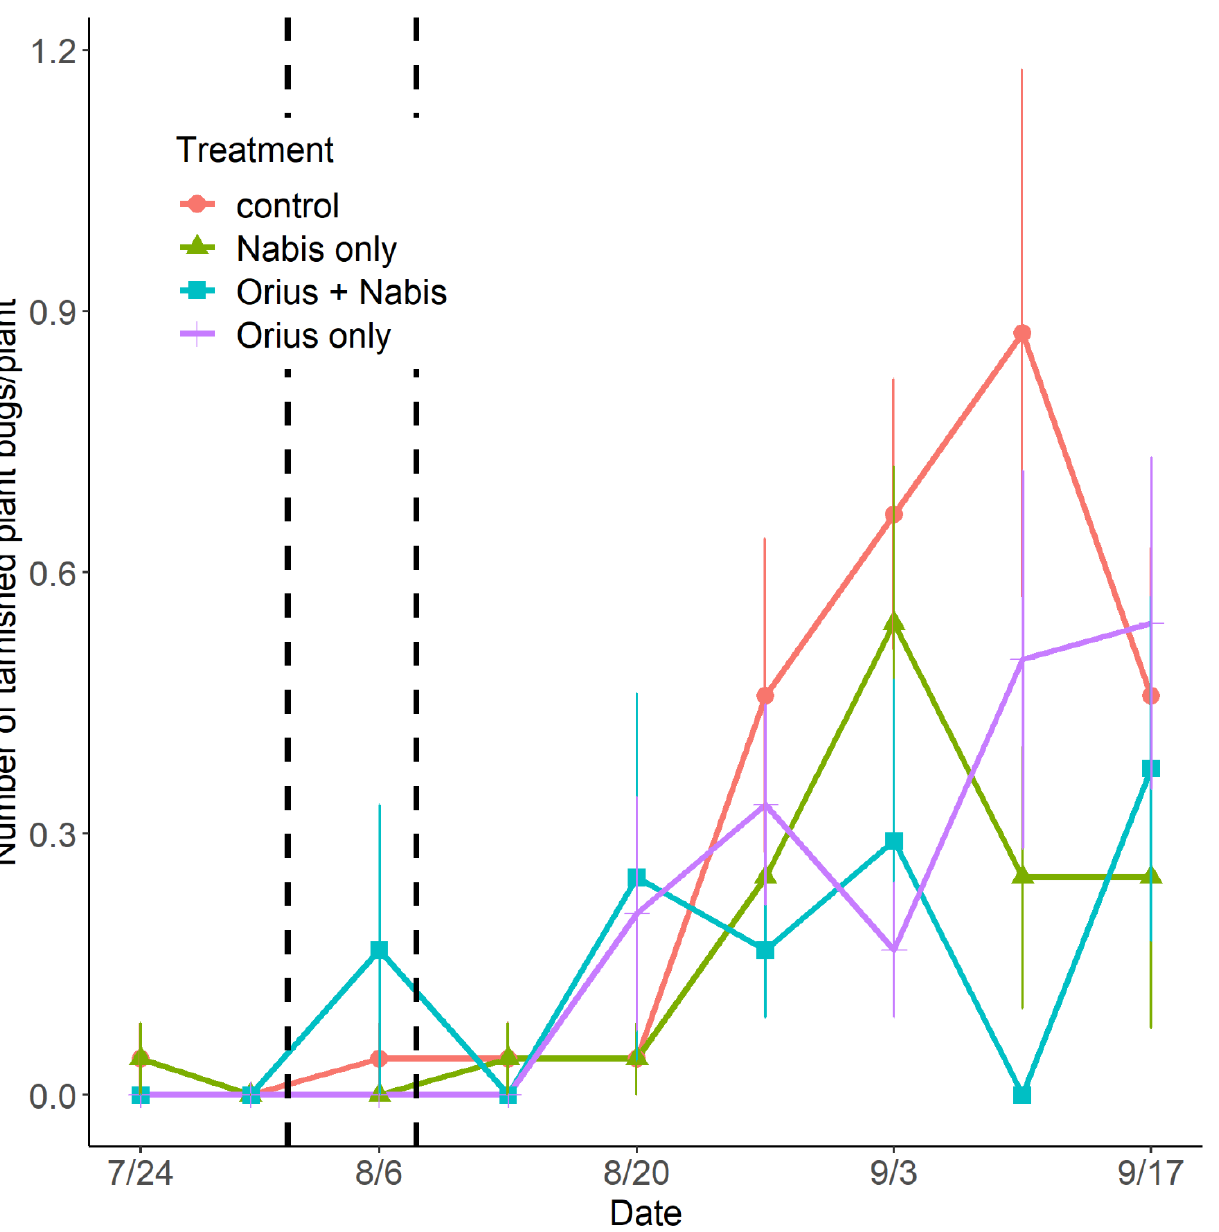
Figure 5. Seasonal variation in the population of the tarnished plant bug observed on strawberry plants depending on the Orius insidiosus and Nabis americoferus treatments. The vertical lines refer to the dates of the release of Orius insidiosus (1 August and 7 August). The error bars correspond to standard errors.